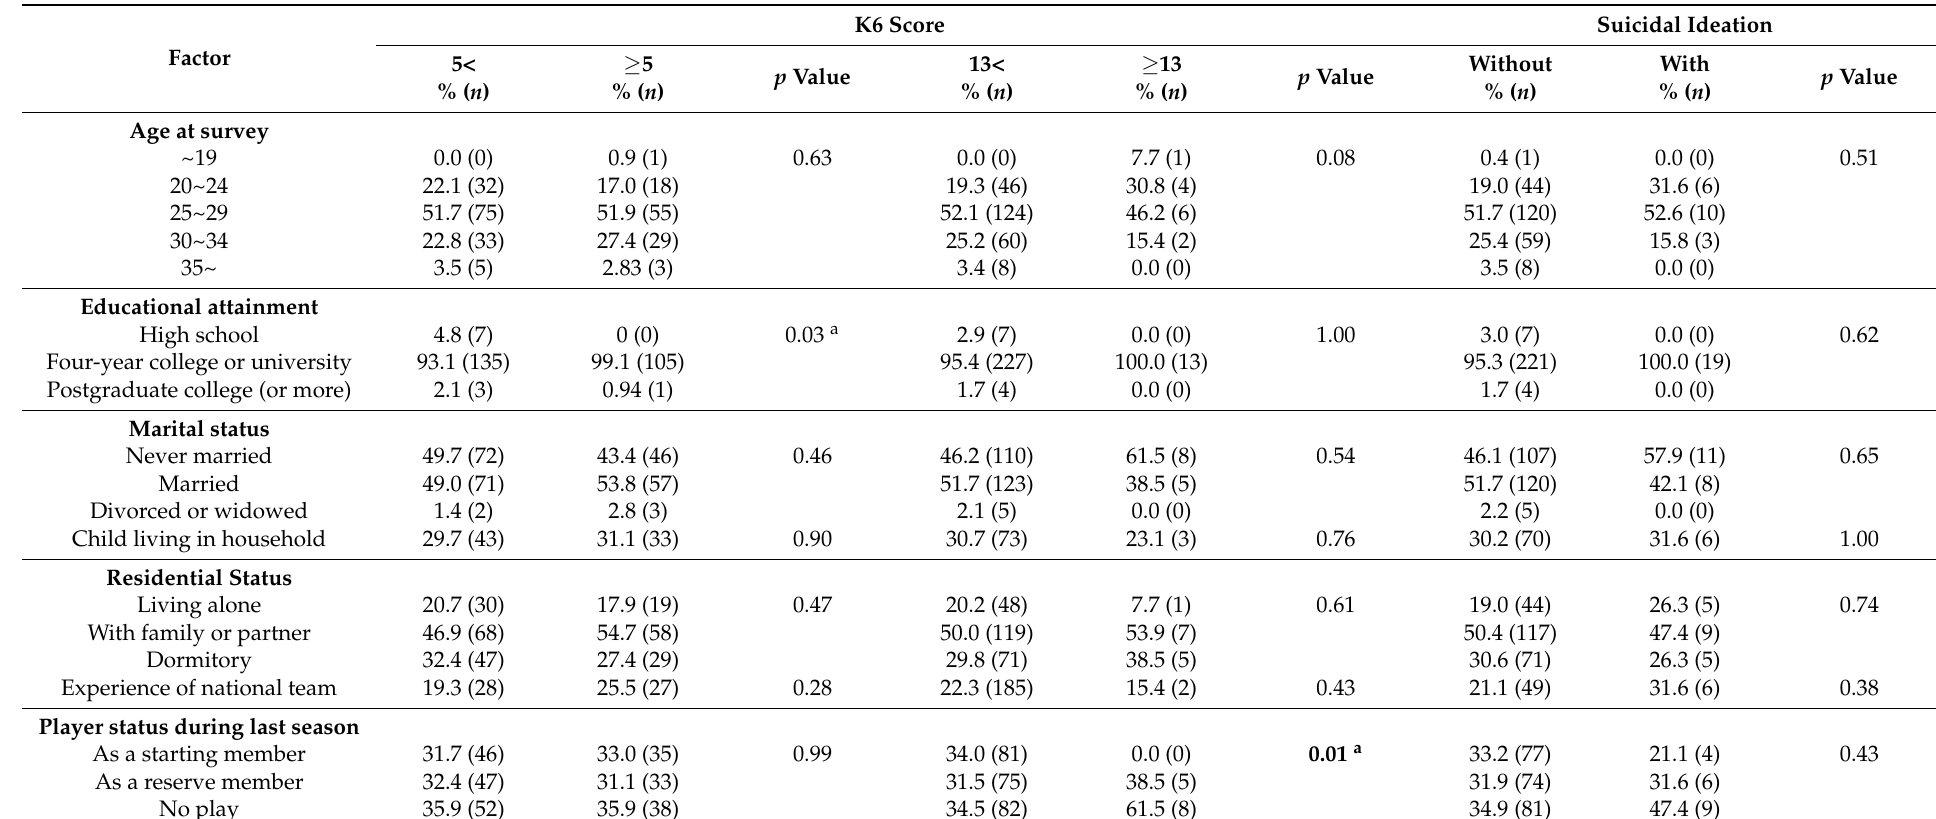
Table 2. Relationship of anxiety and depression symptoms and suicidal ideation to demographic